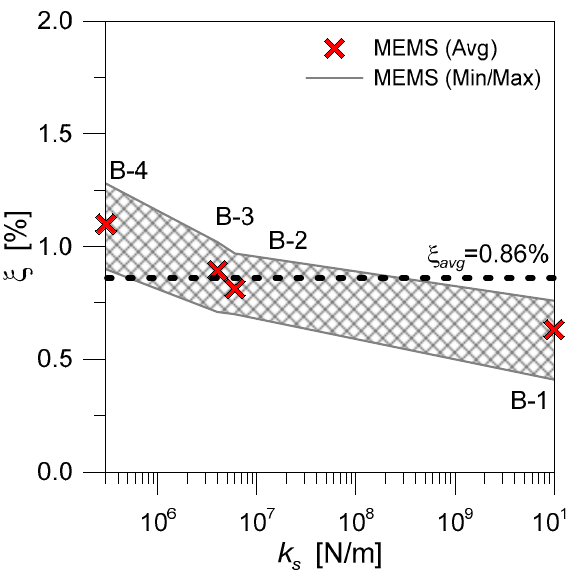
Figure 11. Experimentally derived damping ratio ξ for the tested glass samples, as obtained from post-processing of MEMS records (B-type samples).